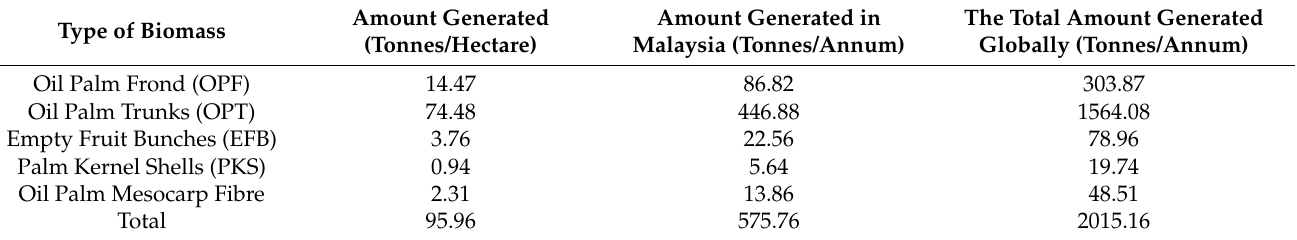
Table 1. Amount of oil palm biomass generated.